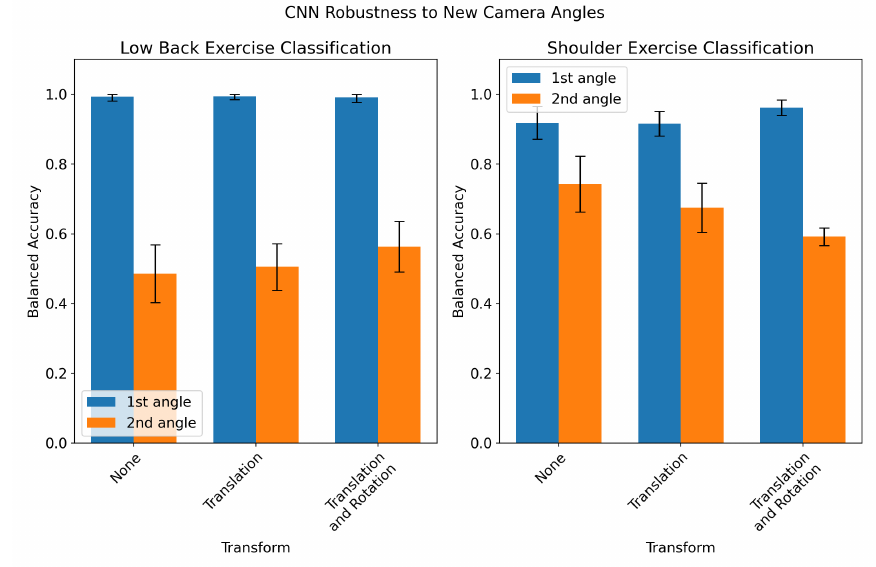
Figure 4. CNN robustness to new camera angles. The CNN was trained on records filmed from one camera angle (“1st angle”, in blue) and tested on a held-out set of records filmed from the second camera angle for each exercise (“2nd angle”, in orange). This was performed using a 5-fold cross-validation approach, splitting the folds by subject to prevent data leakage. This experiment was repeated for low-back exercise classification ( left ) and shoulder exercise classification ( right ), and evaluated the impact of coordinate transforms (no transform, translation, or translation and